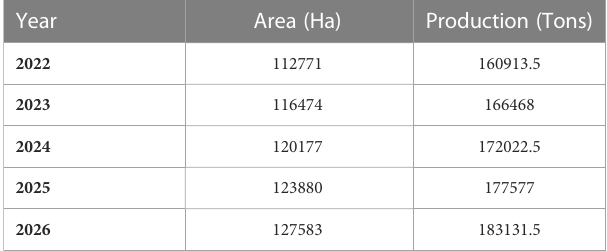
TABLE 1 Predicted shrimp pond area and production for the